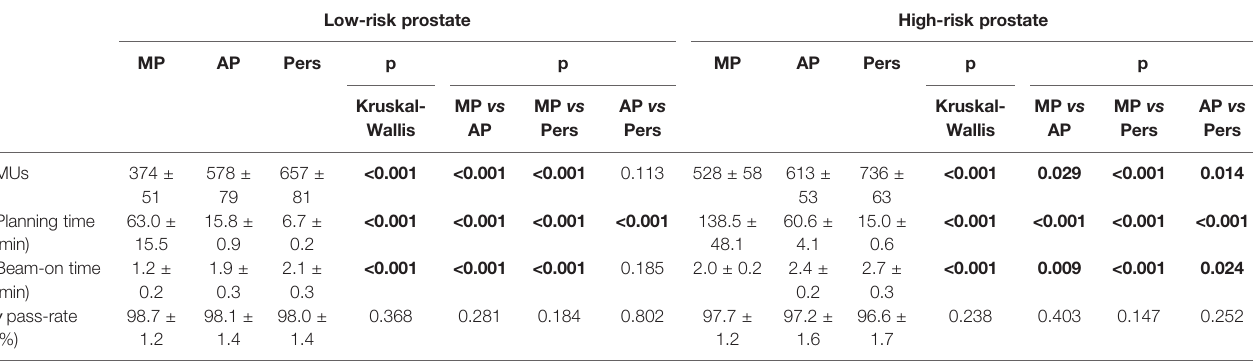
TABLE 5 | Overview of planning ef fi ciency and treatment delivery